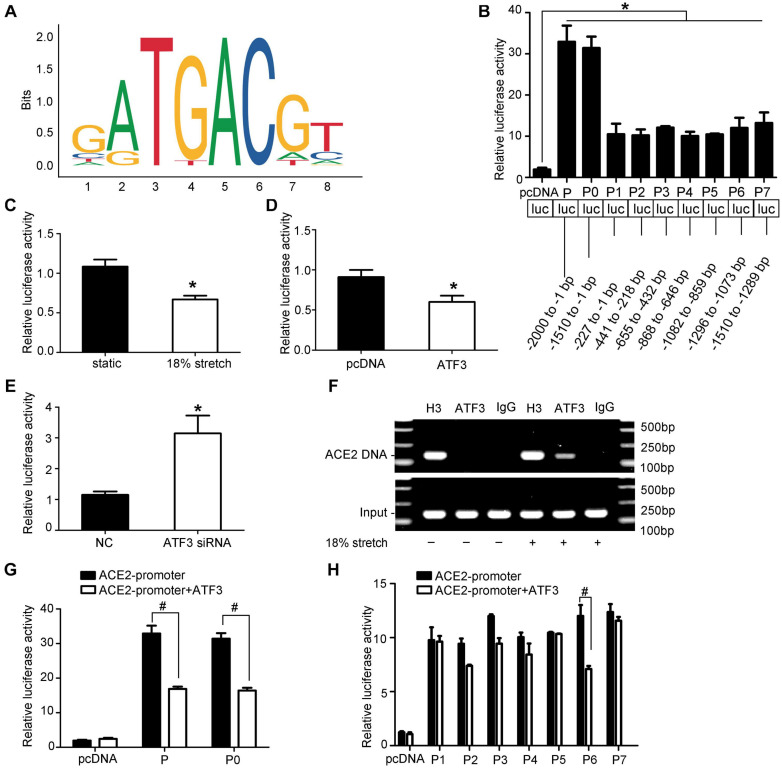
ACE2 is a direct transcriptional target of ATF3. (A) The sequence logo of a potential ATF3 binding site in JASPAR. (B) The relative luciferase activities of the full ACE2 promoter and the truncated constructs in HEK-293T cells. *P < 0.05 vs. pGL3.10-Basic vector. (C) The relative luciferase activities of the full ACE2 promoter P in vascular smooth muscle cells under mechanical stretch for 6 h or not. *P < 0.05 vs. static control. (D,E) The relative luciferase activities of the full ACE2 promoter P co-transfected with pcDNA-ATF3 (or ATF3 siRNA). *P < 0.05 vs. control. (F) ChIP assay showing ATF3 directly bound to the ACE2 promoter (P6, at the -1,296 to -1,073 bp region). IgG, negative control; H3, positive control; ATF3, ATF3 antibody. (G,H) Luciferase activity analysis of P-P7 promoter with or without co-transfection of ATF3. #P < 0.05 vs. the corresponding promoter without co-transfection of ATF3 (n = 4).